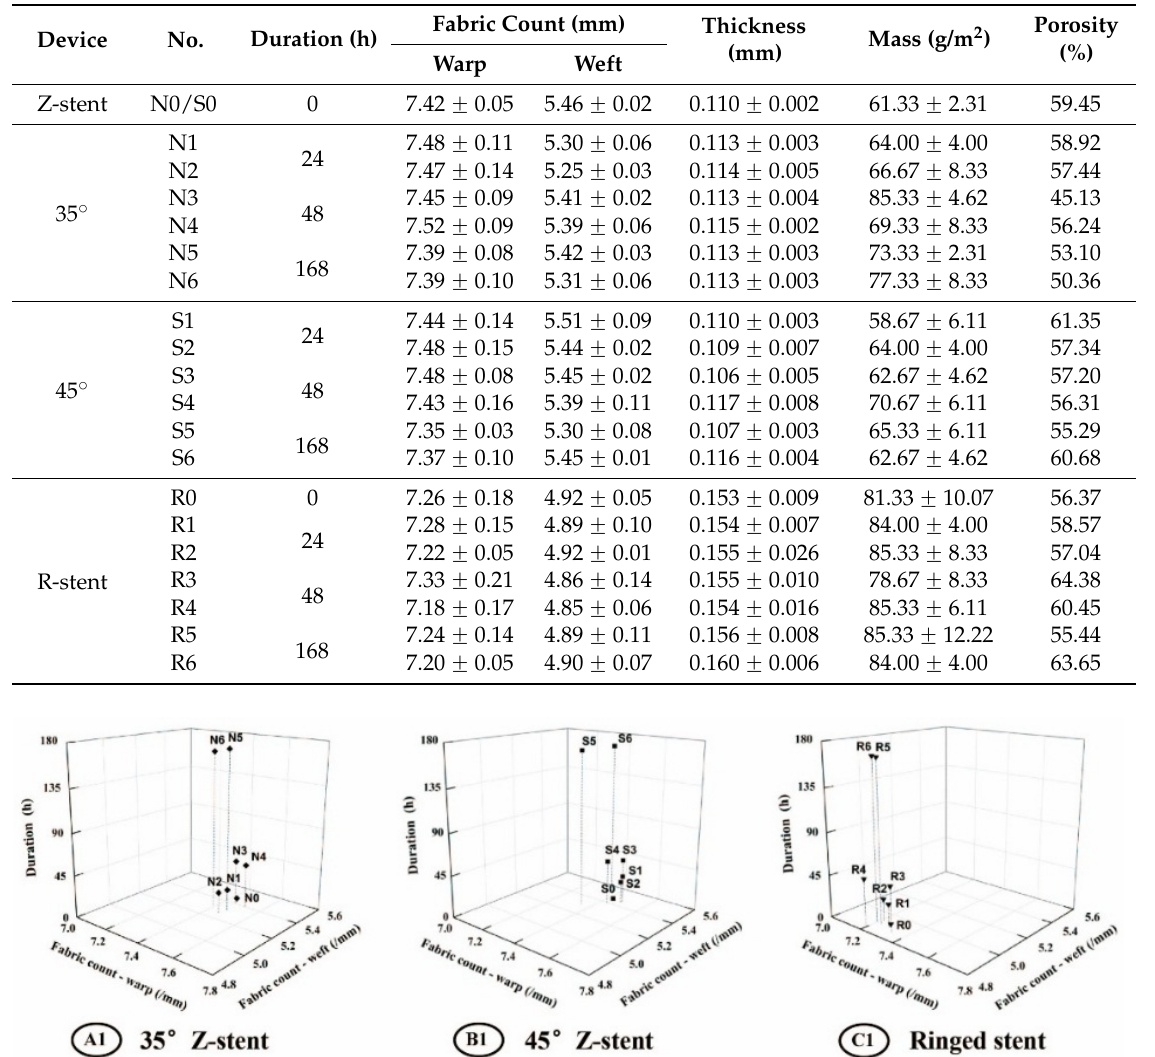
Table 1. Evolution of the structural parameters and crystallinity of the fabrics.